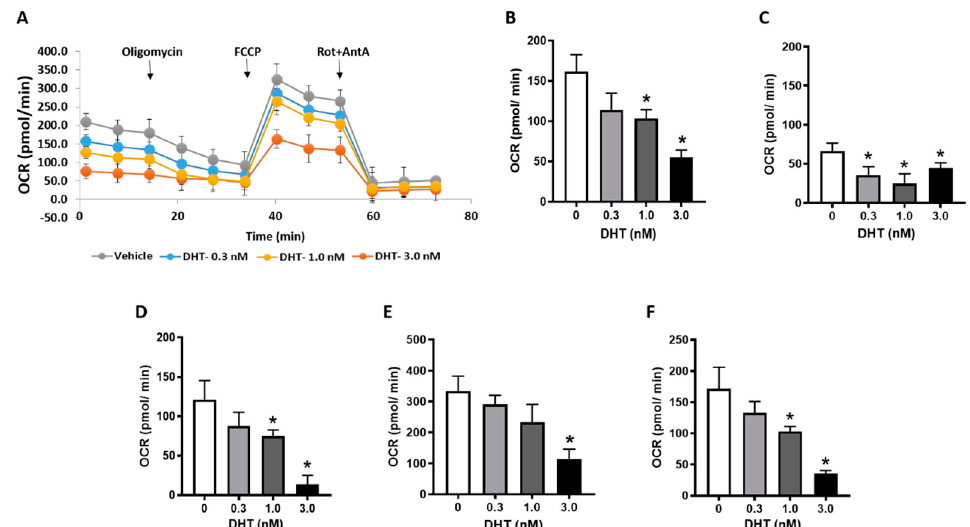
Figure 6. Bioenergetics profile of trophoblasts. Trophoblasts cells were treated with vehicle (ethanol) or dihydrotestosterone (DHT) for 24 h; mitochondrial respiratory parameters were measured using Seahorse. ( A ) Representative traces of mitochondrial respiration, ( B ) basal oxygen consumption rates (OCR), ( C ) proton leak, ( D ) ATP production-linked respiration (OCR after oligomycin administration), ( E ) maximal respiration (OCR after carbonyl cyanide 4-(trifluoromethoxy)phenylhydrazone (FCCP) administration) and ( F ) spare respiratory capacity (Difference between basal and maximal OCR). Data are presented as means ± SEM. The studies were done in duplicate from samples obtained from 4 biologically independent replicates. * p < 0.05 vs. vehicle control.